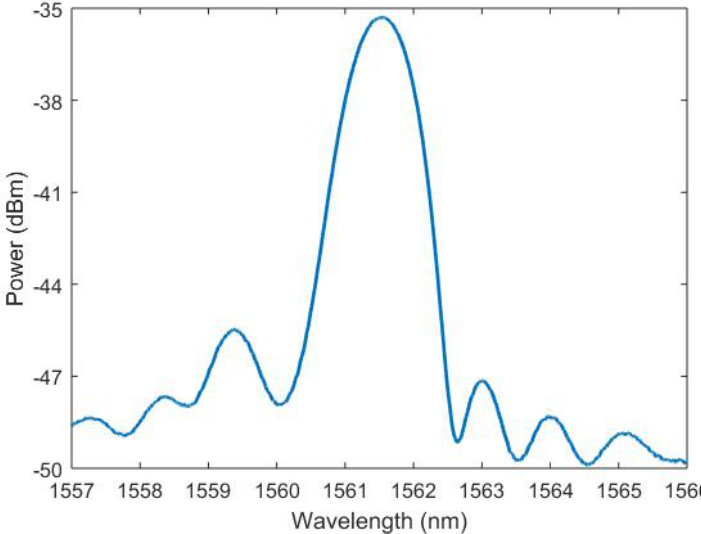
Figure 1. Spectral profile of the CYTOP FBG within the test